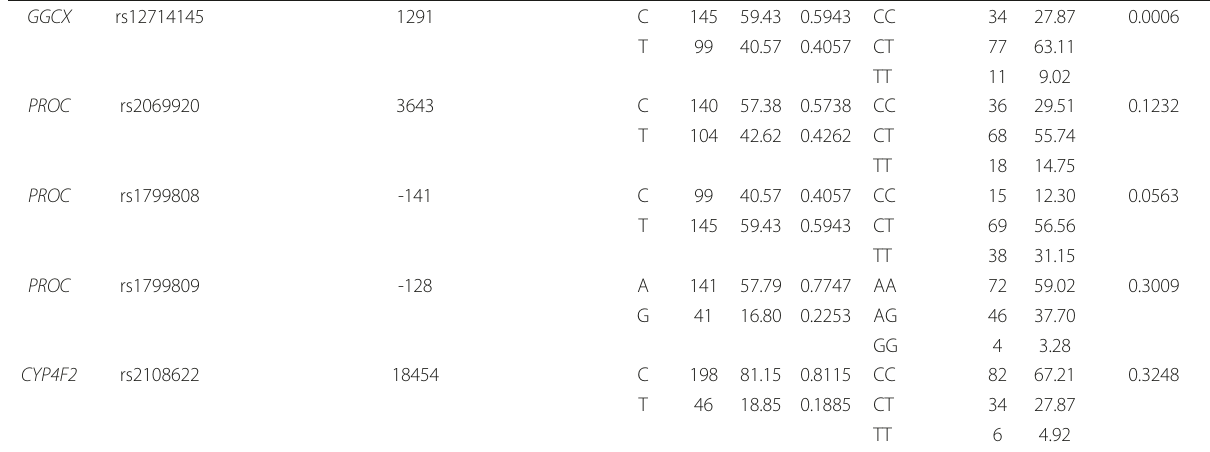
Table 2 Allele frequencies and genotype distribution of SNPs evaluated in this study (Continued)